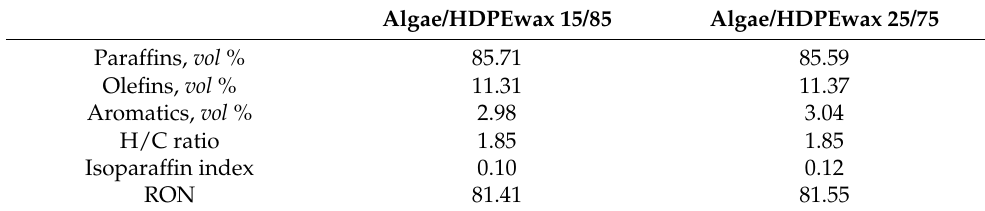
Table 7. Properties of blends determined by 1 H NMR